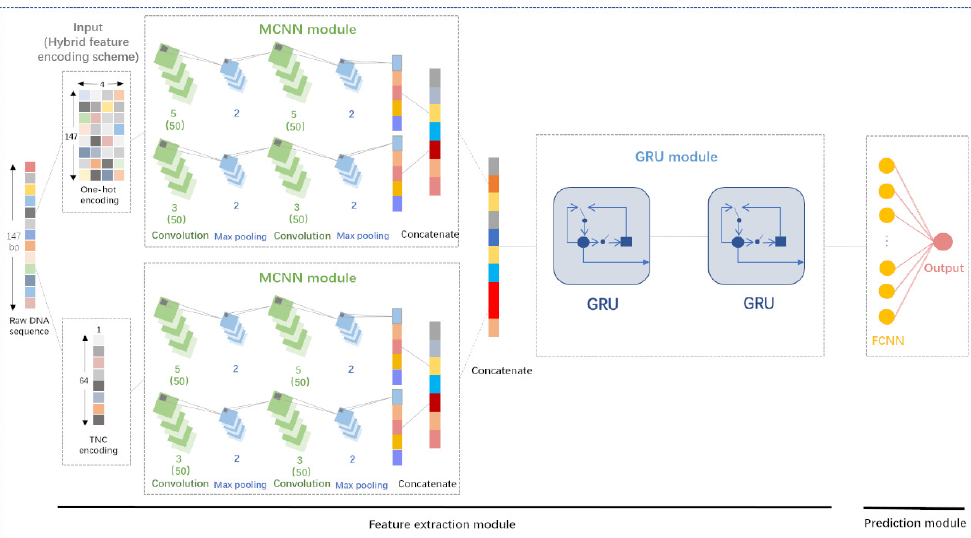
Figure 1. The model architecture of DeepNup. First, a raw 147 bp DNA sequence is encoded into a 147 × 4 dimensional binary matrix and a 64 dimensional vector by using One-hot encoding and TNC encoding, respectively. Next, both the resulting binary feature matrix and feature vector are simultaneously fed into the two parallel MCNN modules to extract local features of DNA sequences. As a result, two feature representations are obtained and merged into a feature representation, which is then fed into the GRU module to extract the global features of DNA sequences. Finally, a FCNN layer and a sigmoid unit are used as a binary classifier to generate a final prediction